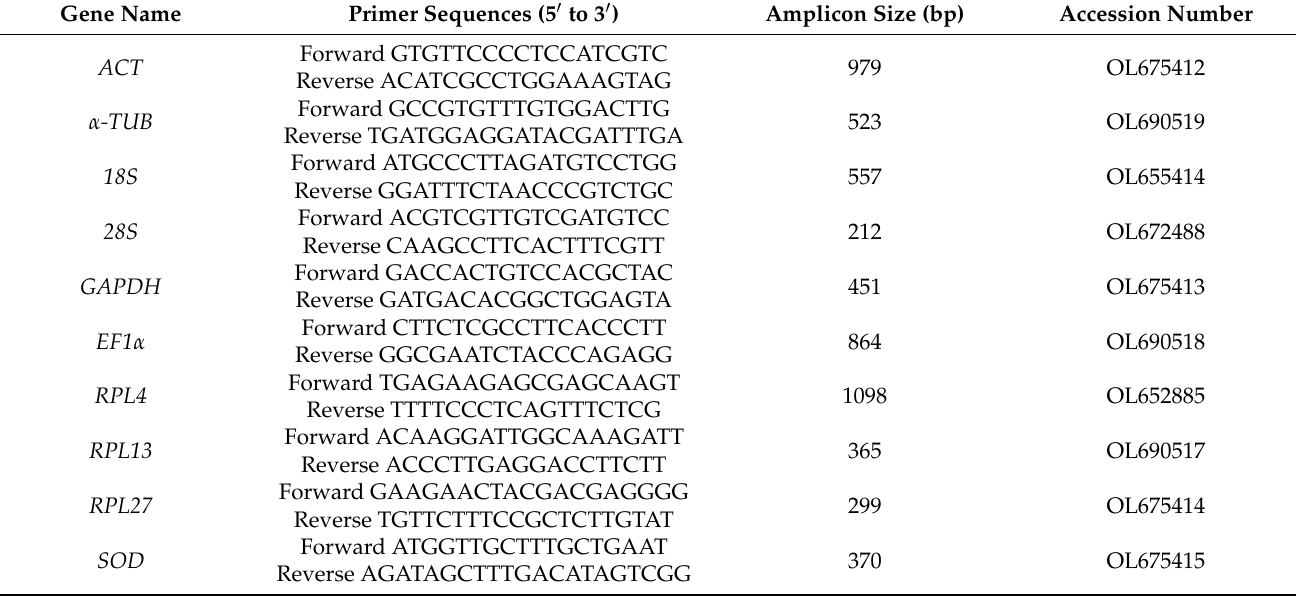
Table 1. A list of primers used for RT-PCR of the